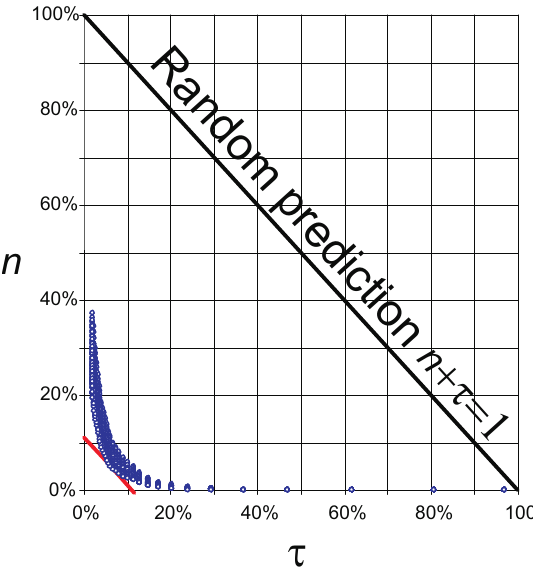
Fig. 12. The error diagram for PAF (hourly variation R ∗ computed from minute values).